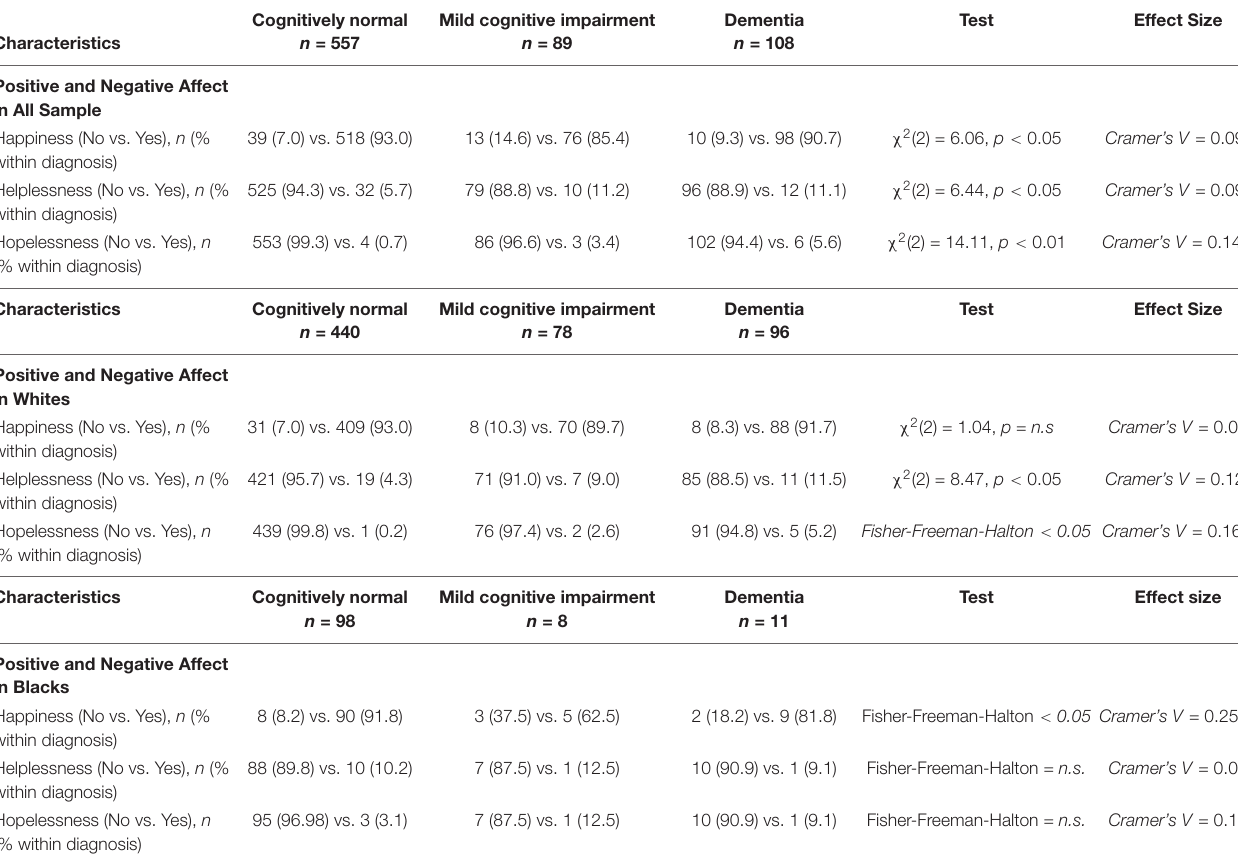
TABLE 2 | Positive and negative affect in all sample, Whites, and